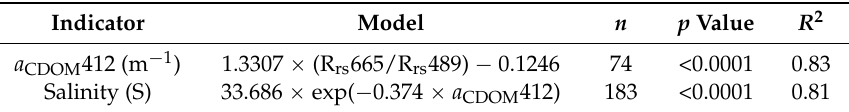
Figure 4. Relationship between measured colored dissolved organic matter absorption ( a CDOM 412) and remotely sensed reflectance (R rs665 /R rs489 ) from water samples ( n = 74) from NB, NR, NBH, SJB, and PB. Dashed line is the 1:1 line. Table 2. Algorithms derived to estimate CDOM absorption and salinity from atmospherically corrected remotely sensed reflectances (R rs ) from NB, NR, and PB estuaries. Shown are the units of measurement; the number of samples used ( n 1 ) to derive the algorithm using linear regression; statistical significance ( p value); and goodness of fit ( R 2 ) of the relationship used to derive the model. Please see Table 1 for estuary abbreviations.